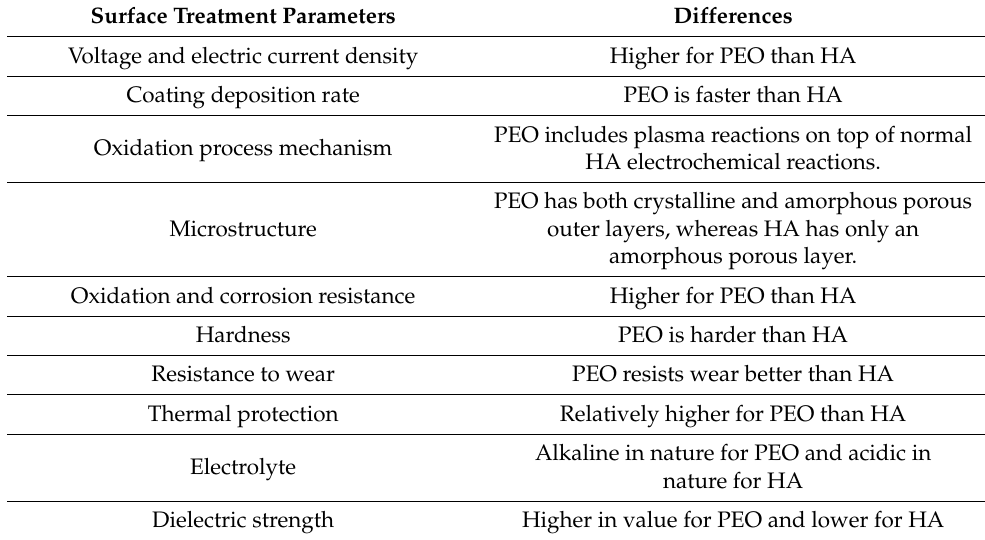
Table 1. Major differences between PEO & hard anodization (HA) process. Adapted from